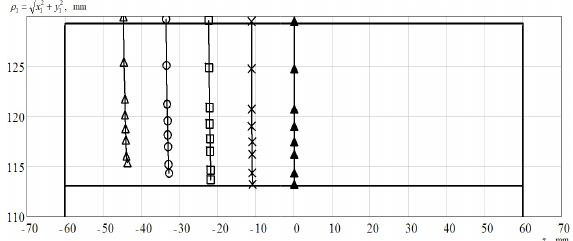
Figure 10. Active lines of action in meshing S δ =0 ( ▲ ); -0,1 ( × ); -0,2( □ ); -0,3( ○ ) and -0,4 mm ( ∆ ) (variant